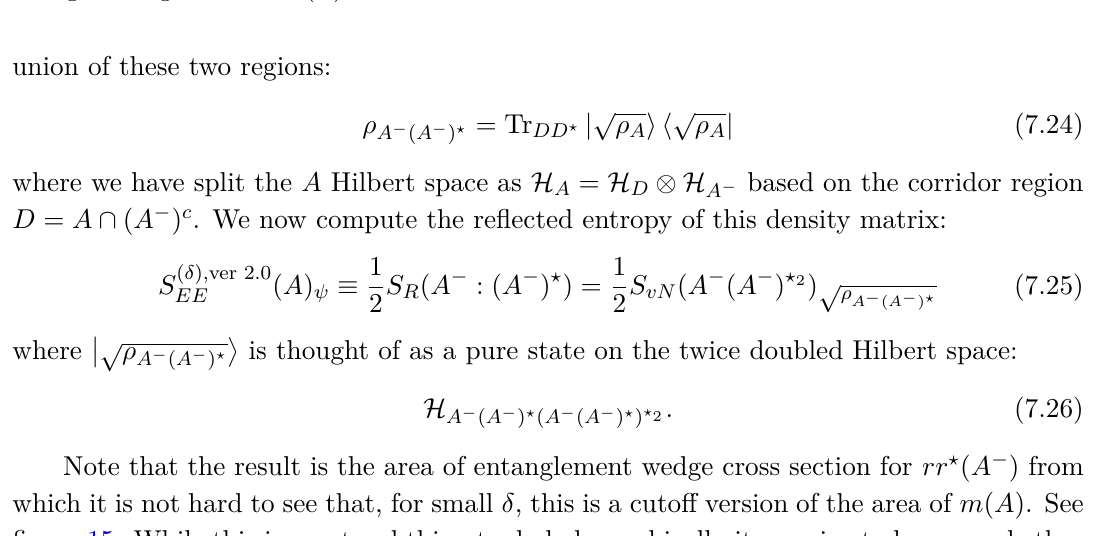
(cid:12) E √ (cid:12) ρ , is a state on the A − ( A − ) ? (cid:12) ( A ) for small δ , thereby EE